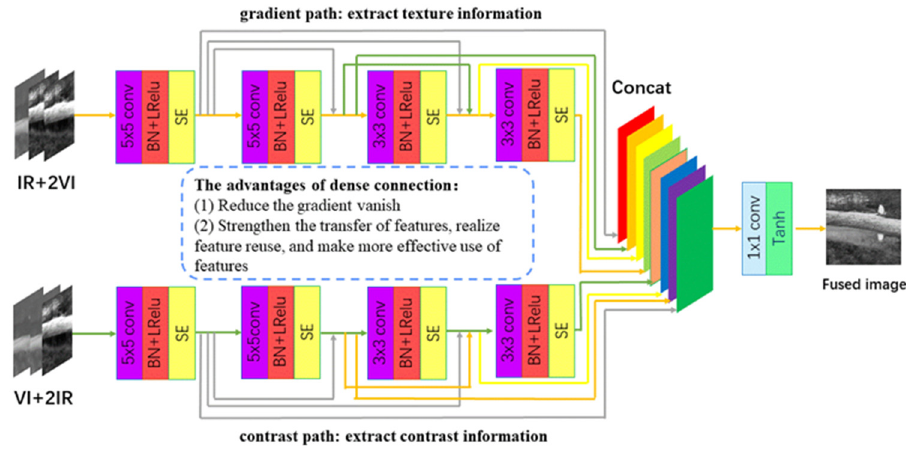
Figure 3. Network architecture of the generator.